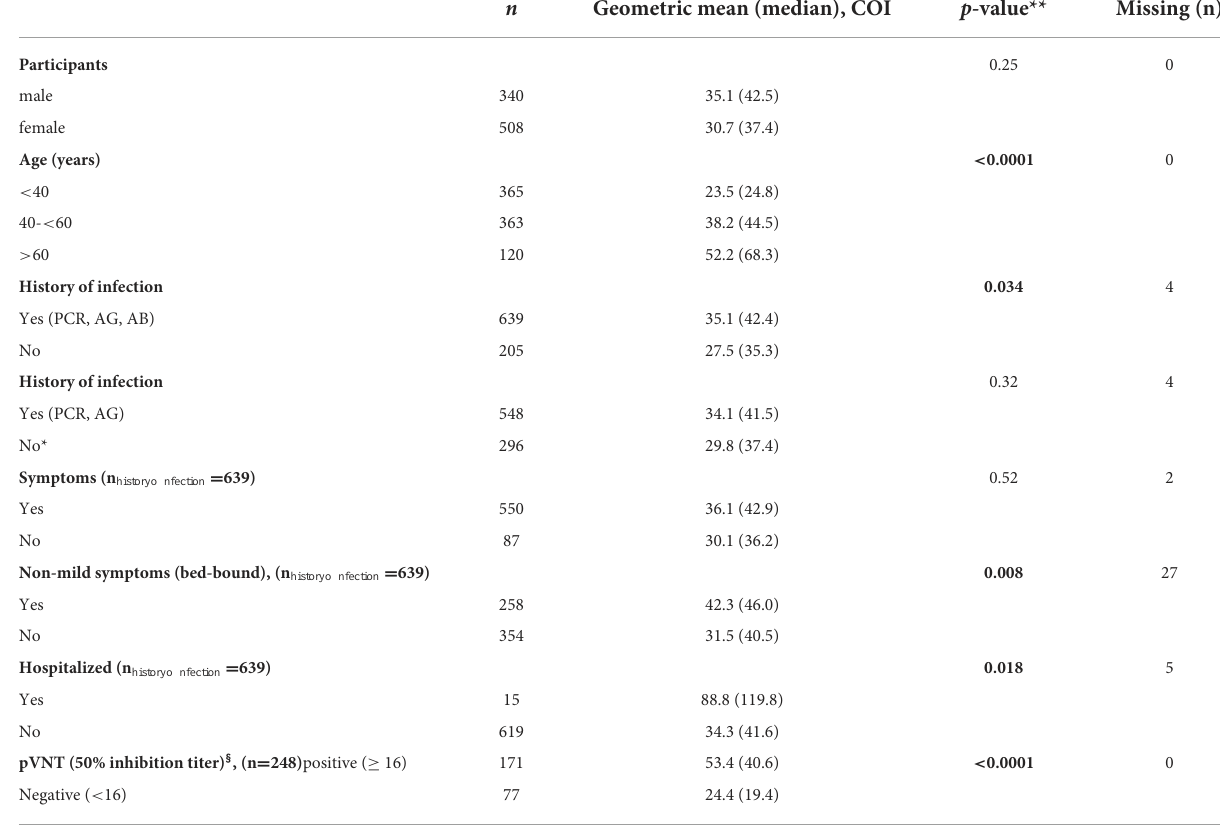
TABLE 2 Geometric mean (median) anti-N antibody concentrations across participant characteristics (n = 848).